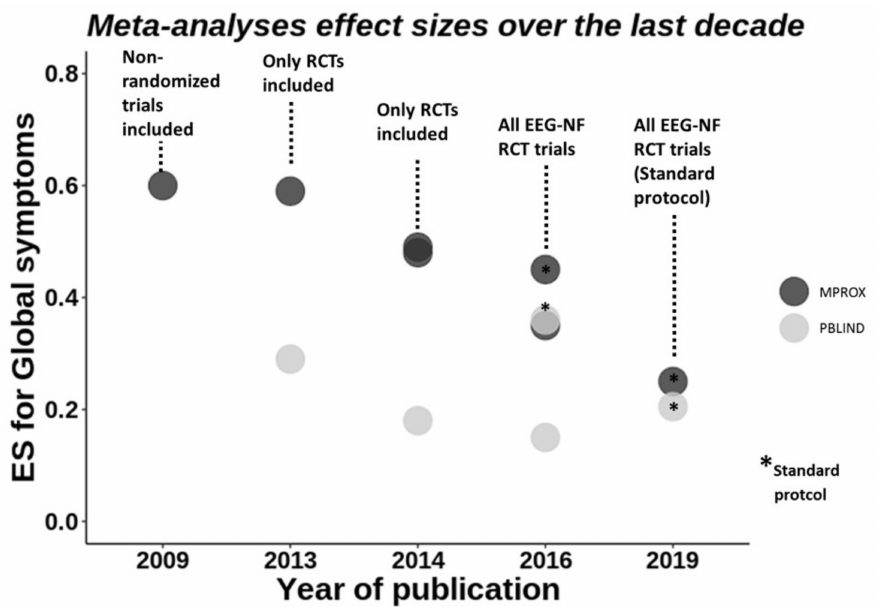
Figure 1. Effect sizes (ES) in meta-analyses of EEG neurofeedback studies for effects on global ADHD symptoms by year of publication. MPROX: ratings by parents/proximal raters; PBLIND: ratings by probably blinded raters. * Studies that used a standard